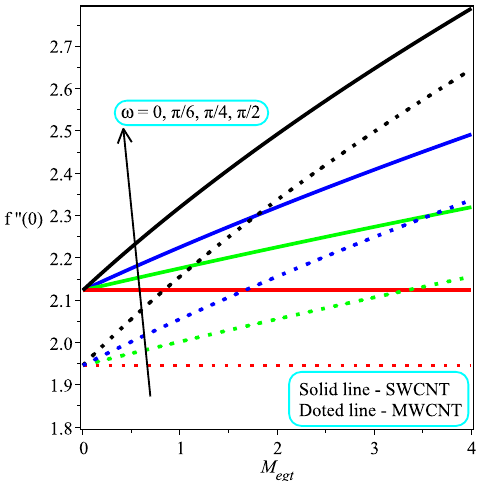
Figure 9. Repercussion of κ with M egt = 2, Ω = 2, ω = π /4 on the local skin friction field.